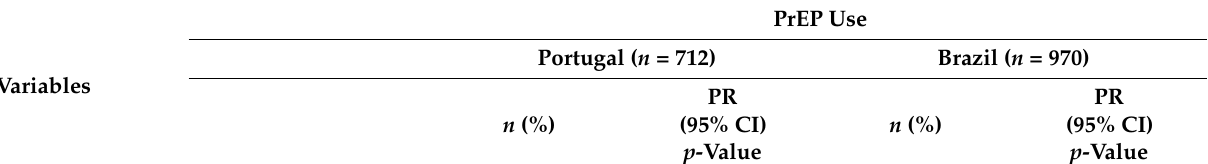
Table 1. Sociodemographic characteristics, practices, sexual behaviors and bivariate analysis of the factors associated with the use of PrEP,